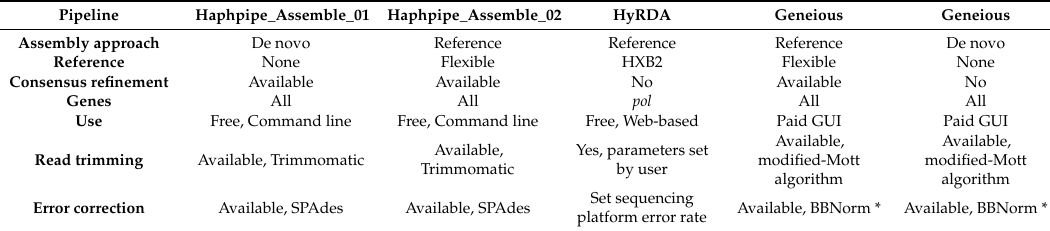
Table 1. Characteristics of the compared